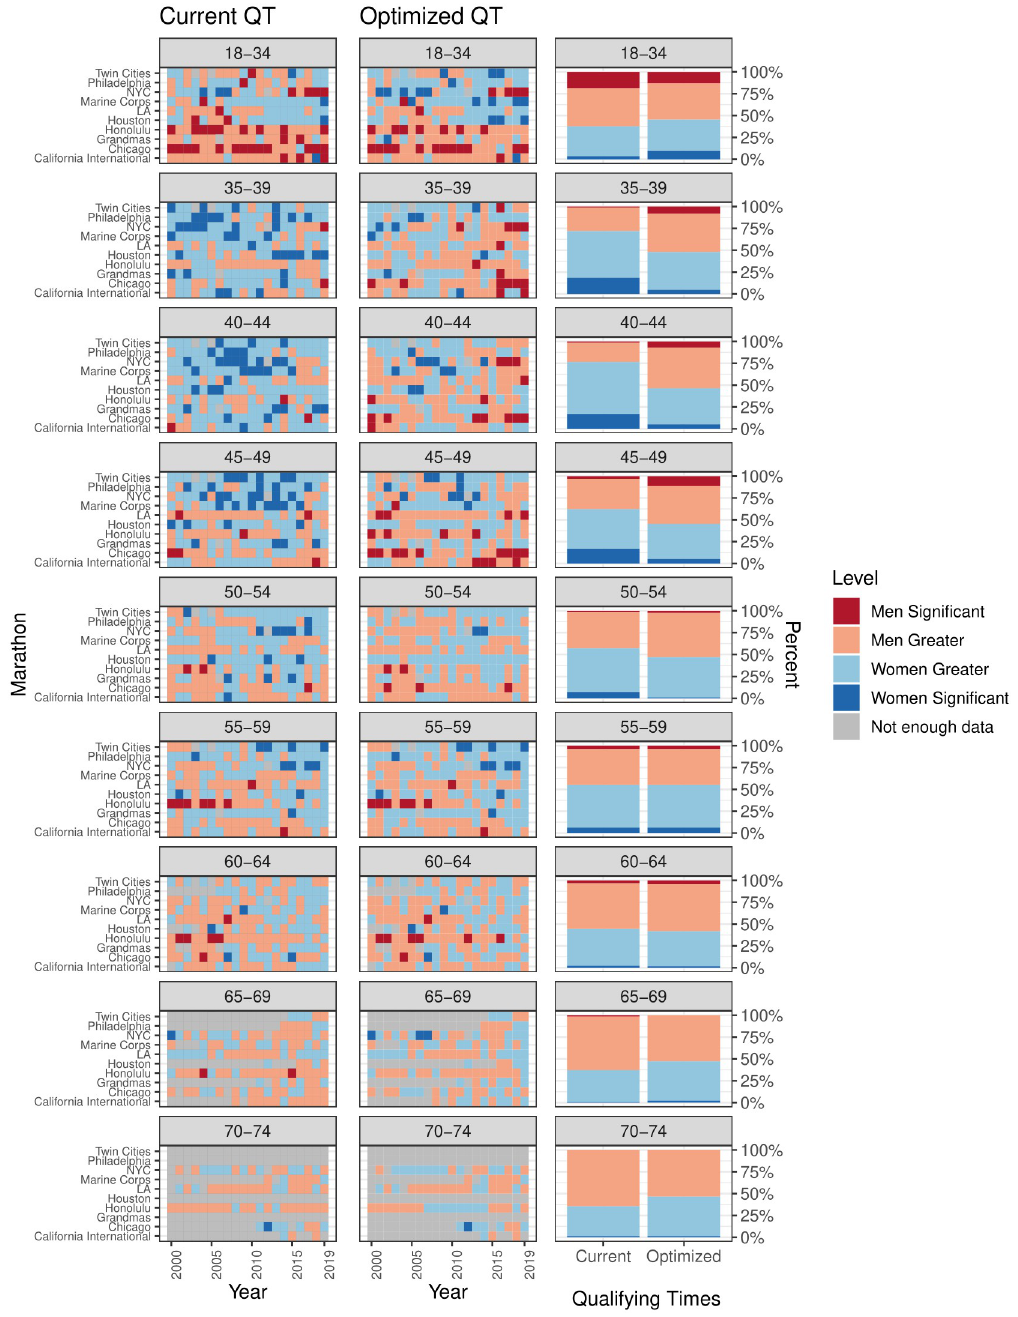
Fig 4. The first column shows the results of the proportion test using the current Boston marathon qualifying times, the second column shows the results using the optimized difference in proportions qualifying times given in Table 2, and the third column shows the total number of results for each level at the current and optimized difference in proportions qualifying times. Red squares represent a higher proportion of men qualifying, blue squares represent a higher proportion of women qualifying. Dark red and dark blue indicate whether this difference is significant at a 95% significance level while light red and light blue indicate a difference in proportion that is not significant at the 95% level.